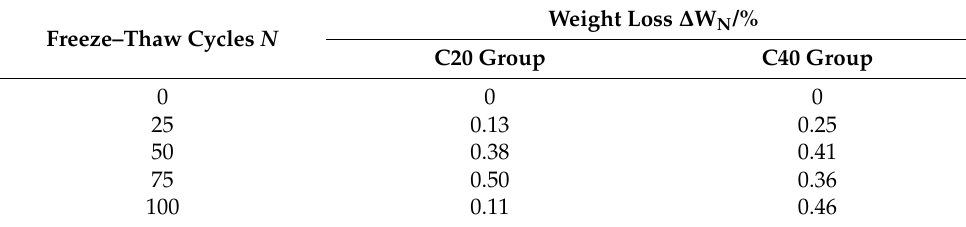
Table 3. Mass loss of the specimens after freeze–thaw cycles.